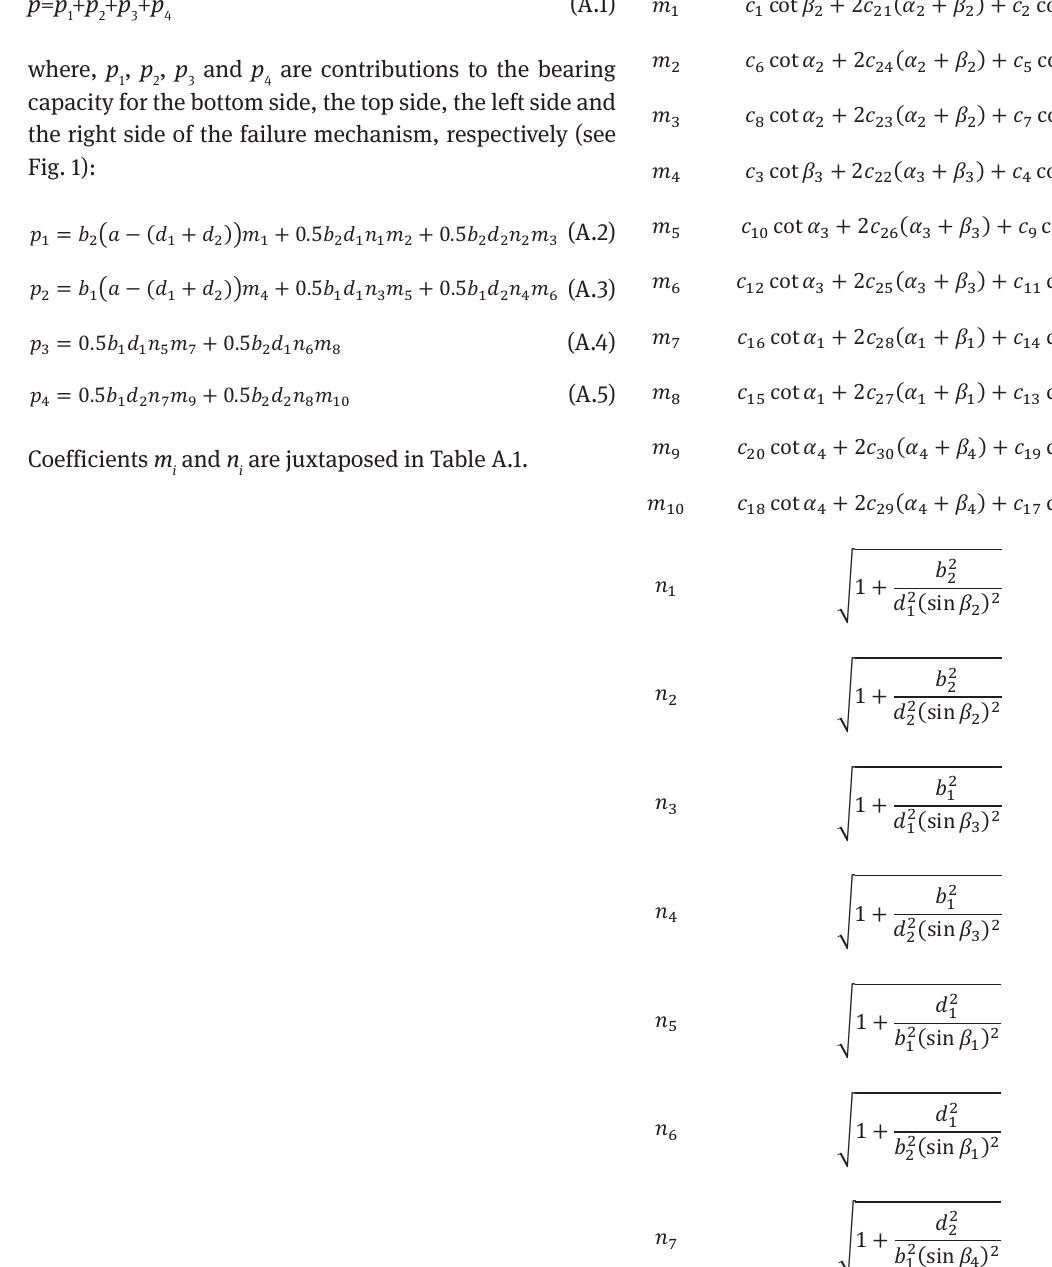
Table A.1. Coefficients from Eq. (A.2)–Eq. (A.5) for rough and smooth foundation base. Note that the undrained are defined individually for each dissipation region (for more details see Chwała, 2019a). shear strengths 𝒄𝒄𝒄𝒄 𝒊𝒊𝒊𝒊 Coeff.